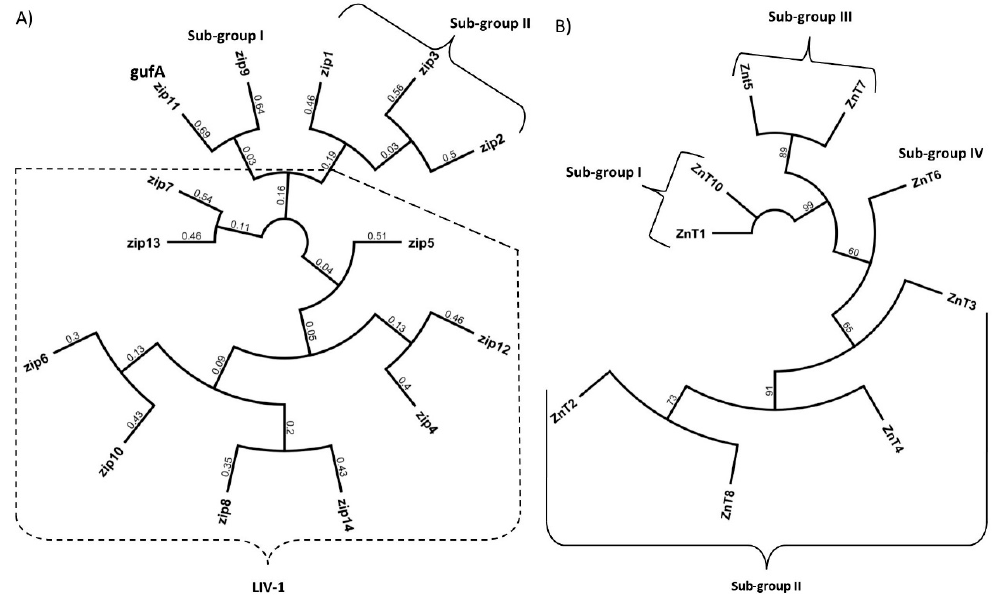
Figure 1. Phylogenetic relationships of the human ZnT and ZIP proteins (SLC30A & SLC39A family of zinc transporters). Protein sequences were attained by converting human SLC39A and SLC30A mRNA into amino acids sequences and aligned by Geneious alignment using global alignment. The dendrogram was generated from Geneious tree builder utilizing the Jack-knife method. Molecular phylogenetic analysis as generated by the genetic distance model “Jukes-Cantor”, the re-sampling method used Jack-knife with 229,871 random seeds. (A) Phylogenetic relationships of SLC39A family (ZIP), (B) Phylogenetic relationships of SLC30A family (ZnT).